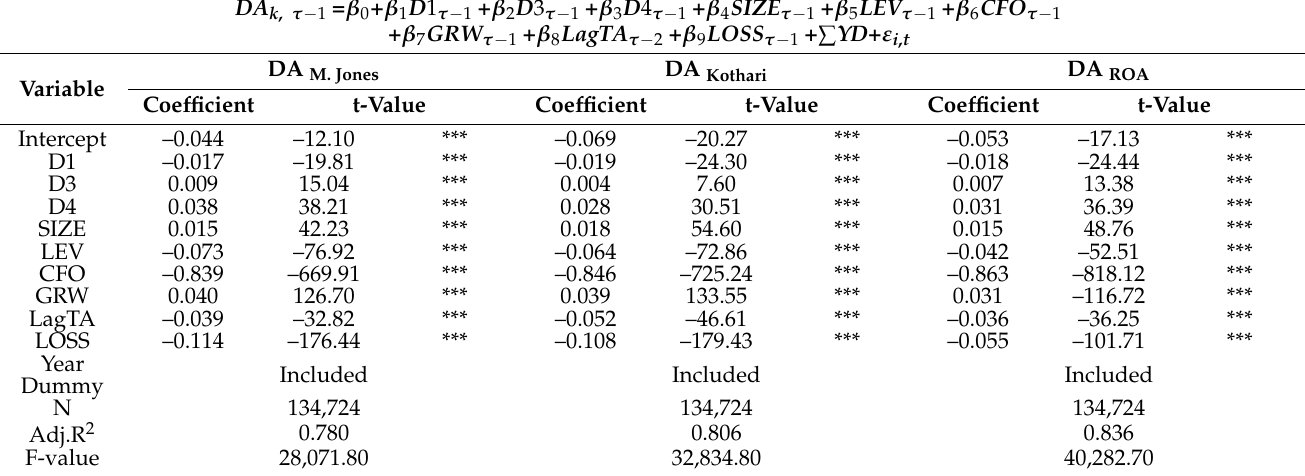
Table 7. Differences in discretionary accruals according to external audits and firm size.